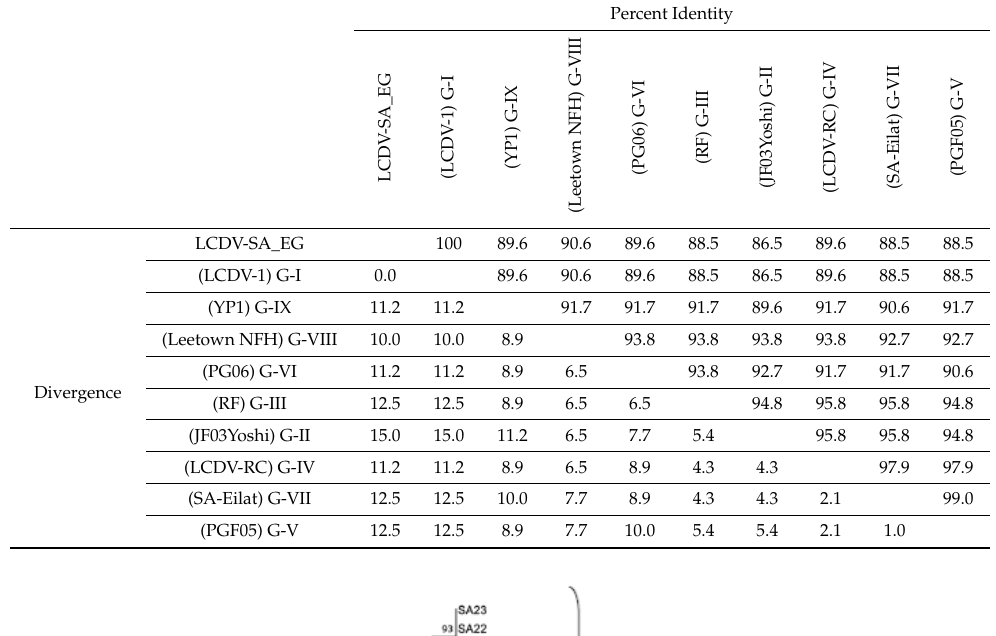
Table 2. Amino acid identity and divergence between LCDV-SA_EG MCP sequence and representa- tive sequences from other LCDV genotypes.